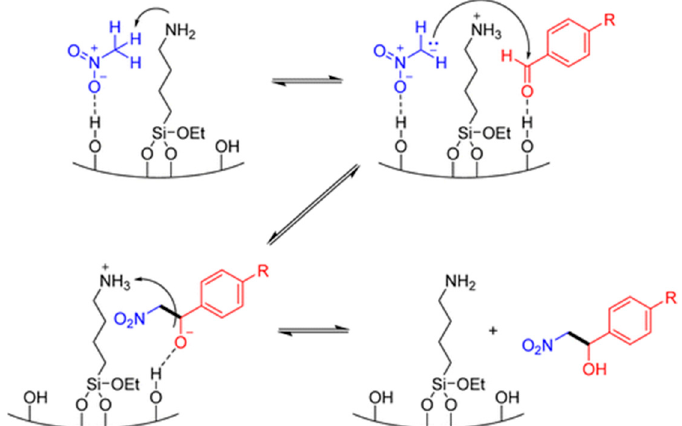
Figure 16. Proposed mechanism for the aldol condensation of acetone and para -substituted benzaldehydes on amino-silica cooperative catalyst. Reproduced with permission from [24]. Copyright 2015 American Chemical Society.